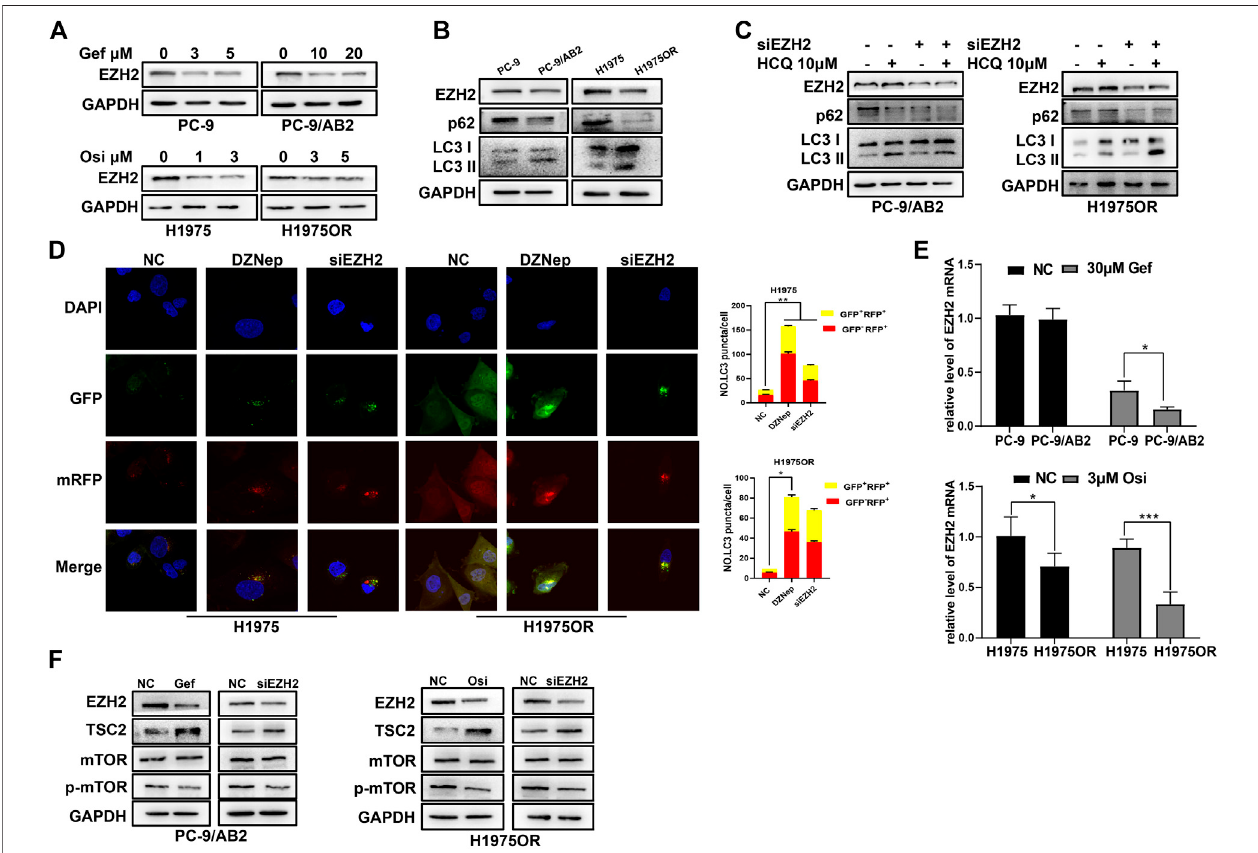
FIGURE2| EZH2isanegativeregulatorofautophagy. (A) EGFR-TKIscancausedecreasedexpression ofEZH2protein inPC-9/H1975 andcorrespondingdrug- resistantcells. (B) WesternblottingrevealedlowerlevelsofEZH2proteinandhigherautophagicactivationindrug-resistantcells. (C) Westernblottingshowedenhanced autophagic activity of drug-resistantcells following transfection with siEZH2. (D) Fluorescence assay showing representative images of cells transfected with GFP-RFP- LC3 double-labeled adenovirus. Autophagic fl ux was increased after knockdown of EZH2 in H1975 and H1975OR. Quantitative analysis of the number of yellow autophagosomes and red autolysosomes. * p < 0.05, ** p < 0.01. (E) RT-qPCR assays revealed lower levels of EZH2 mRNA in drug-resistant cells. (F) Western blotting showed that downregulation of EZH2 induced by EGFR-TKIs affects the mTOR signaling pathway and its suppressor TSC2.